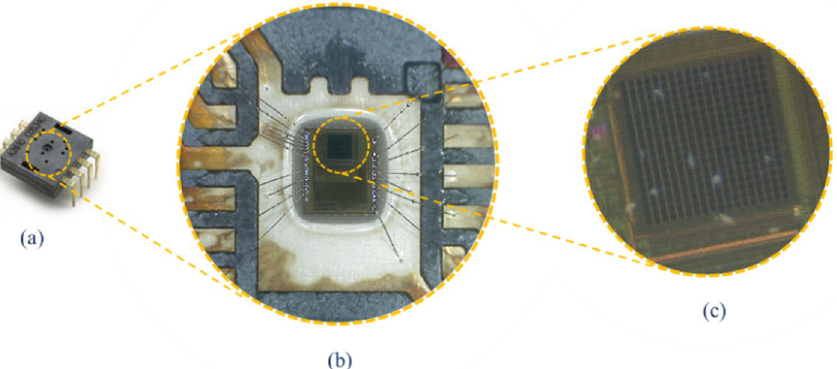
Figure 3. Optical motion measurement sensor (similar to the one used in computer optical mouse today), ( a ) dual inline package IC, ( b ) Microscopic view and ( c ) 18 × 18 pixels CMOS camera.